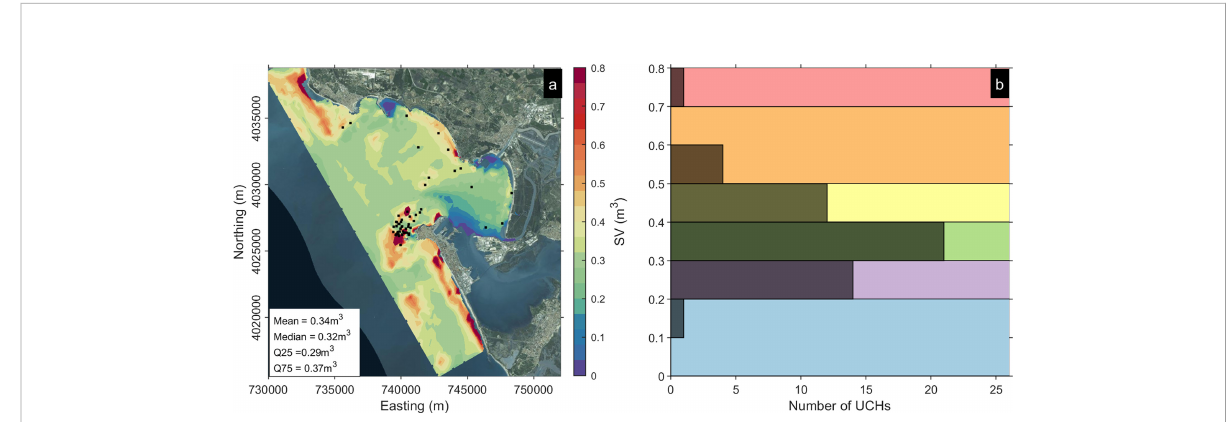
FIGURE 5 (A) Map of scour hazard (scour volume) in the outer Bay of Cadiz. (B) Histogram of the hazard at underwater cultural heritage sites and hazard classes (background color).